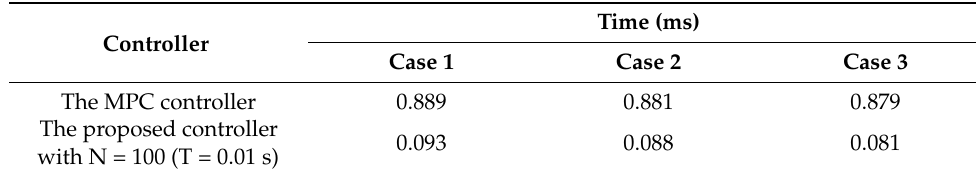
Table 8. The MPC controller average calculation time and the proposed controller in a single step for noise cases 1–3.